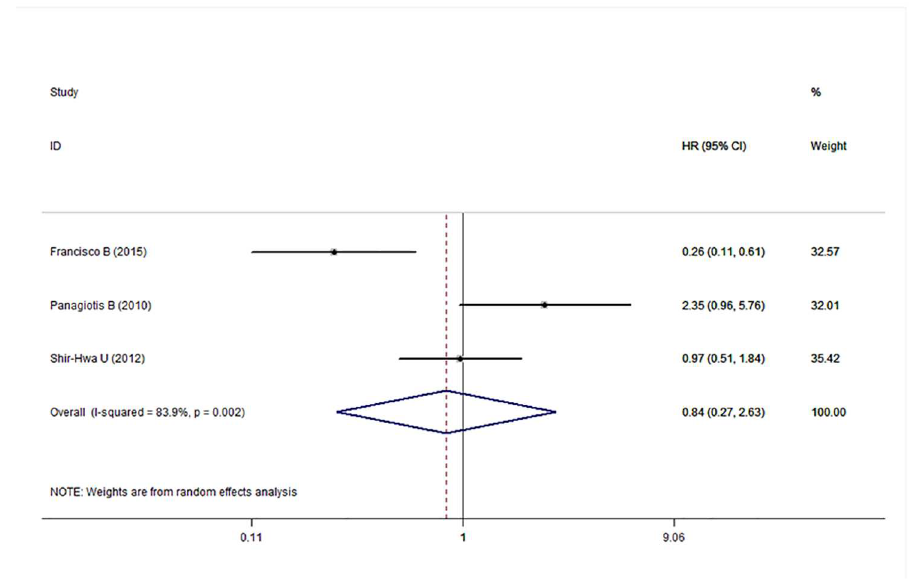
Fig 3. Meta-analysis of the overall pooled HR of studies for the survival outcomes of breast cancer. Forest plot showingno statistical significance of the associationbetweenp-mTOR expressionand overall survival of breast cancer patients from the random-effects model.